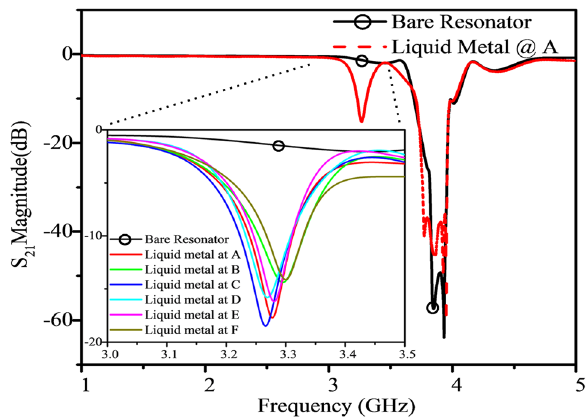
Figure 5. The fabricated resonator with and without liquid metal loading at resonator A, inset shows each tuned resonator had a resonant frequency and amplitude response between 3.26 and 3.29 GHz and − 18 to − 15 dB, consistent among all 6